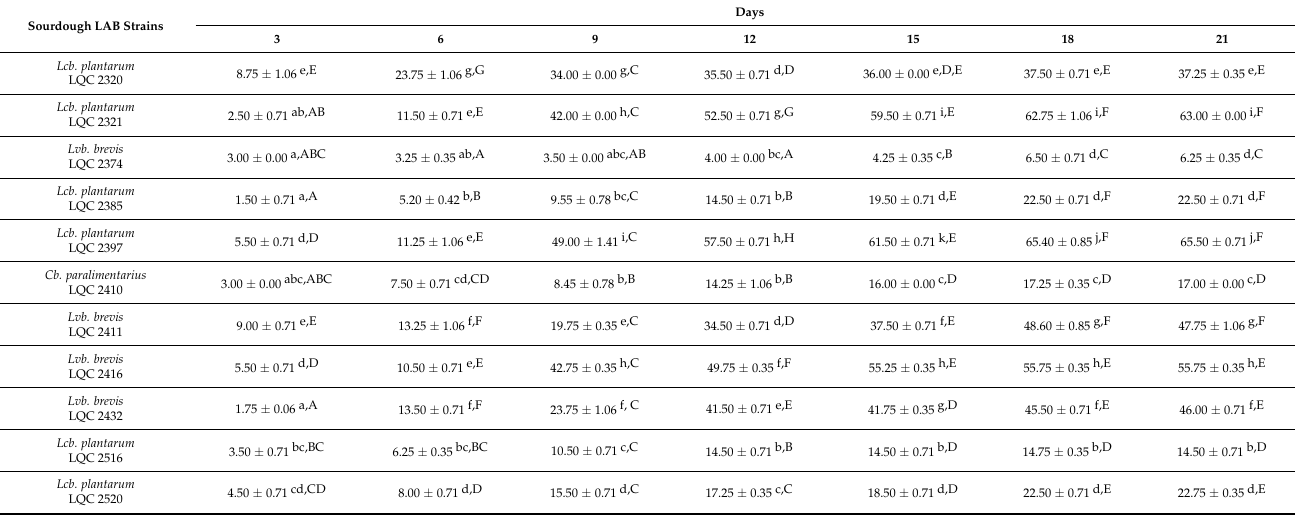
Table 1. Lipolysis kinetics of 11 bacterial strains during 21 days of incubation, at 30 ◦ C.